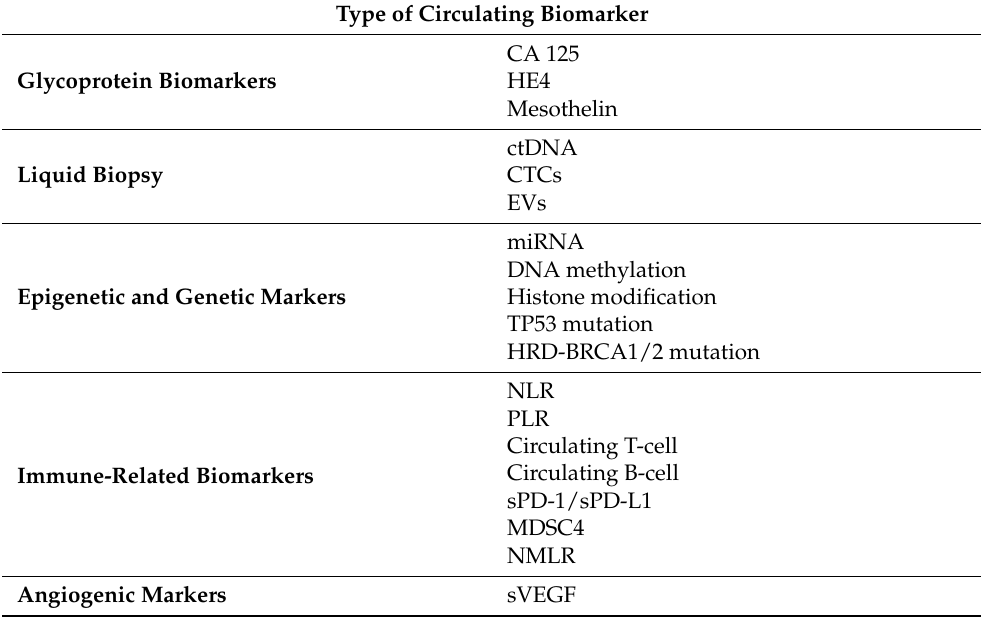
Table 2. Discussed circulating biomarkers in